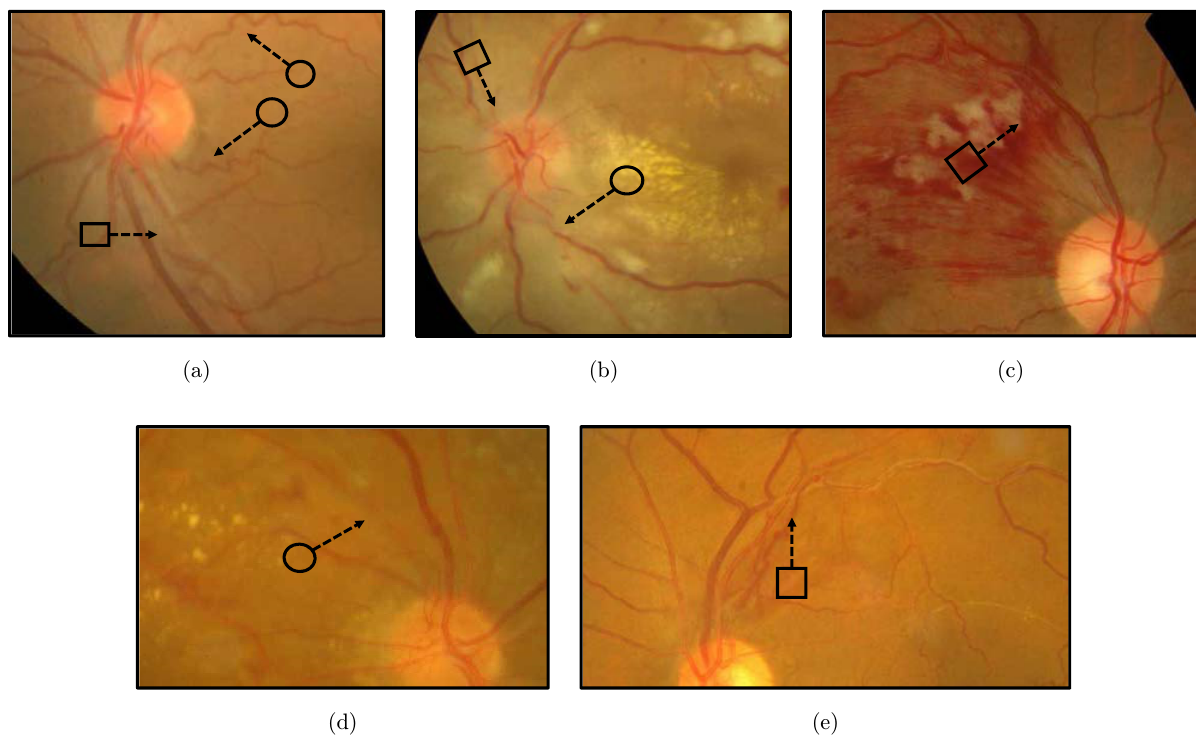
Fig. 2. Image slices showing pathologies (circle and square arrows indicate di®erent abnormalities). (a) Arrow with circle: vessel tortuosity and Neovascularization, Arrow with rectangle: Retinal artery occlusion, (b) Arrow with circle: Shrinkage and occlusion of retinal artery, Arrow with square: Optic Disk Swelling, (c) Arrow with square: Branch Retinal Vein Occlusion, (d) Arrow with circle: Branch Retinal Artery Occlusion and (e) Arrow with square: Sclerotic retinal